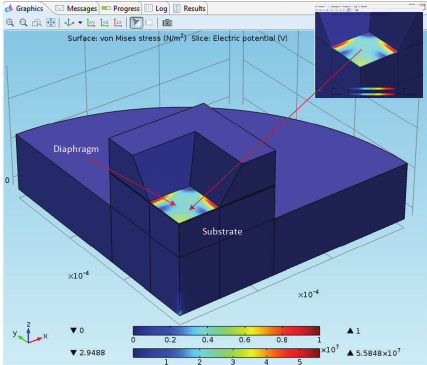
Figure 14: Structure surface of diaphragm with maximum von Mises stress with applied pressure.